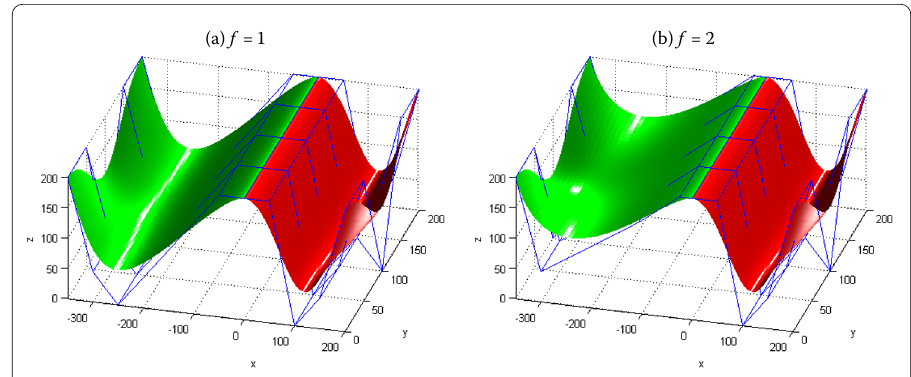
Figure 5 G 2 continuity condition in the v direction between two adjacent generalized Bézier-like